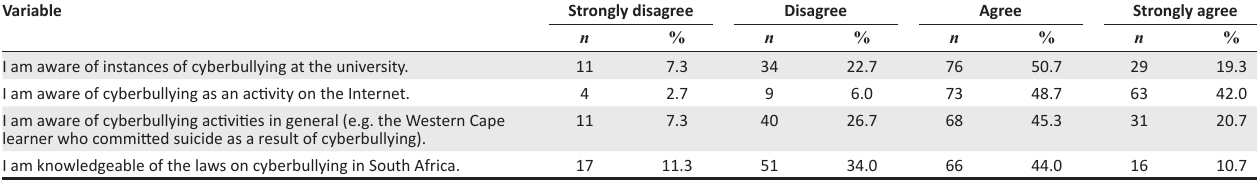
TABLE 4: Awareness of cyberbullying among students.